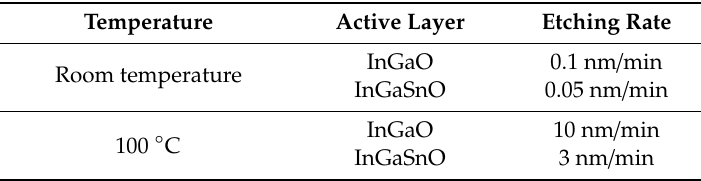
Table 2. Etching Rate of the InGaO and InGaSnO Films in Aqueous Al(NO 3 ) 3 · xH 2 O